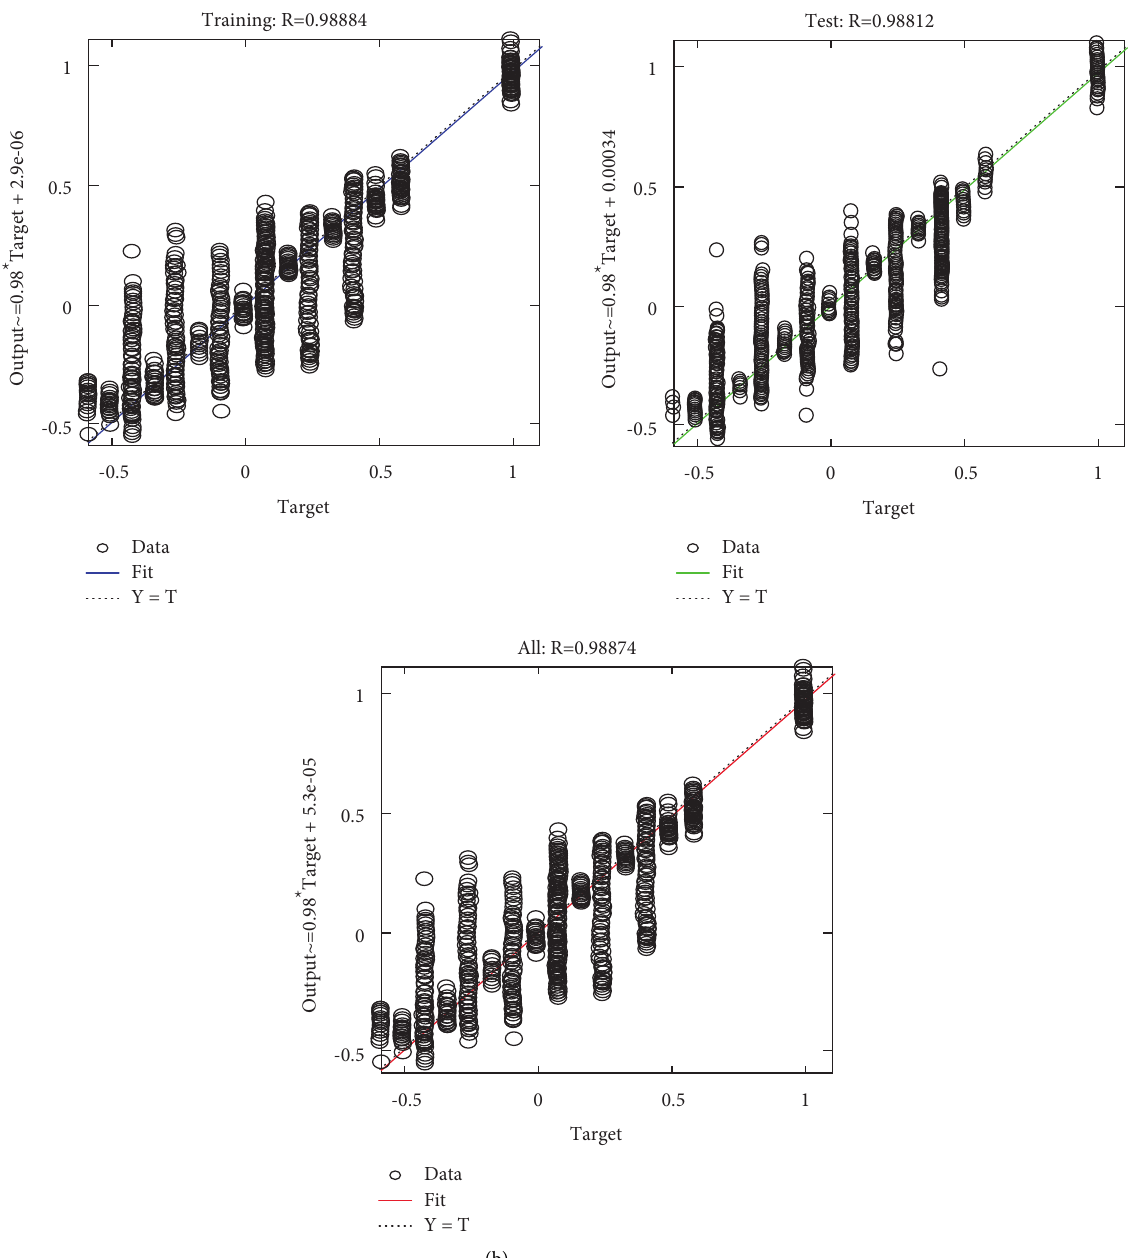
Figure 8: Results from training datasets using MATLAB based on the methods of data